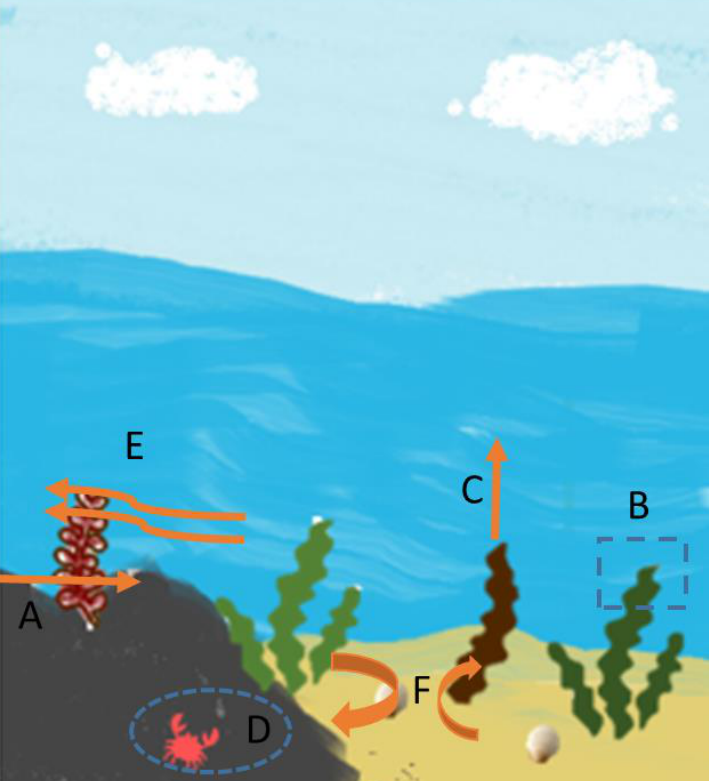
Figure 1. Schematic presentation of some of seaweed ecological services: ( A ) sediment formation (supporting services/function); ( B ) biomass production (provisioning services); ( C ) photosynthesis and production of oxygen (regulating services); ( D ) provisioning of habitat (supporting services/function); ( E ) erosion regulation (supporting services/function); ( F ) nutrient cycling (supporting services/function).